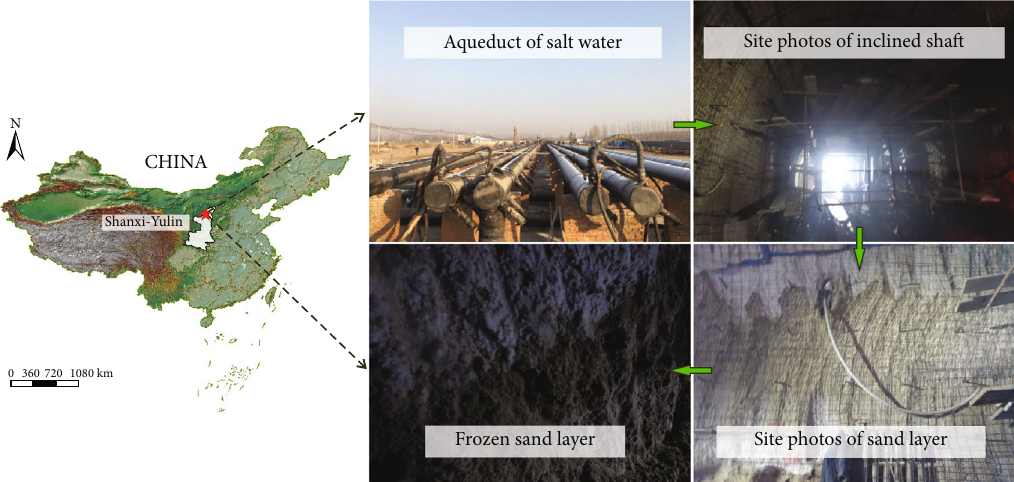
Figure 1: Location of the inclined shaft sinking engineering and the photos of the site